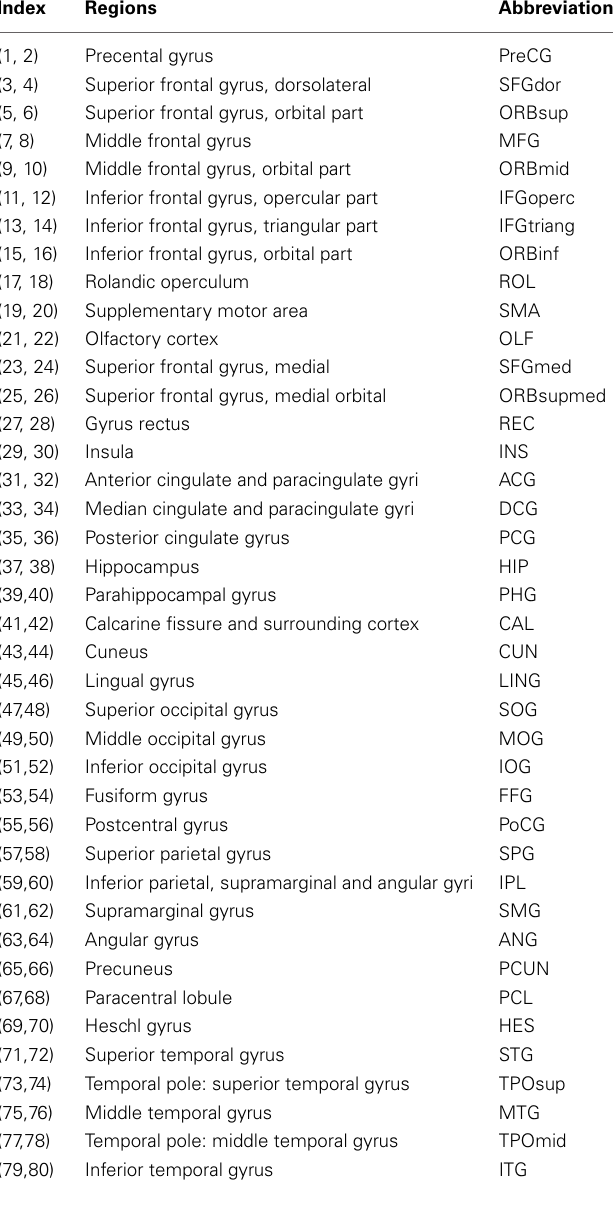
Table 2 | Cortical region-of-interest defined in the